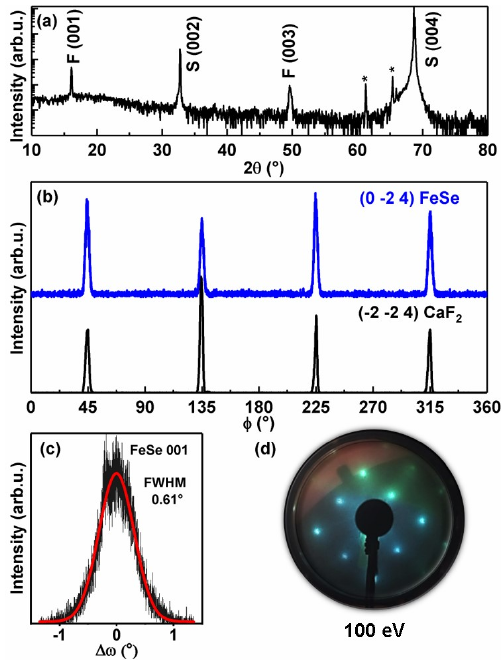
Figure 1. ( a ) θ –2 θ XRD pattern of a FeSe film deposited by PLD on a CaF 2 (001) substrate; The symbols ‘F’, ‘S’, ‘*’ indicate the film, substrate and characteristic x-rays peaks, ( b ) asymmetric Φ scans along (0 − 2 4) of FeSe and ( − 2 − 2 4) of CaF 2 reflections, ( c ) rocking curve performed around the (001) peak of the FeSe film, ( d ) LEED pattern of the FeSe film on a CaF 2 (001) substrate measured at 100